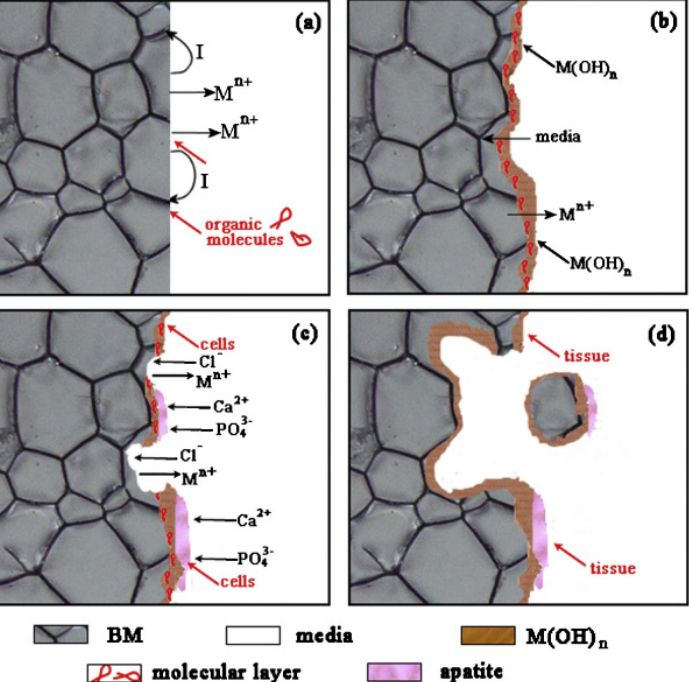
Figure 8. Schematic diagram of biocorrosion between Mg-based materials and the biological envi- ronment (adapted after [8]): ( a ) galvanic corrosion between the metal matrix and the intermetallic phase, or grain boundary; ( b ) beginning of biodegradable metal dissolution; ( c ) beginning of pitting corrosion; and ( d ) material degradation at the grain